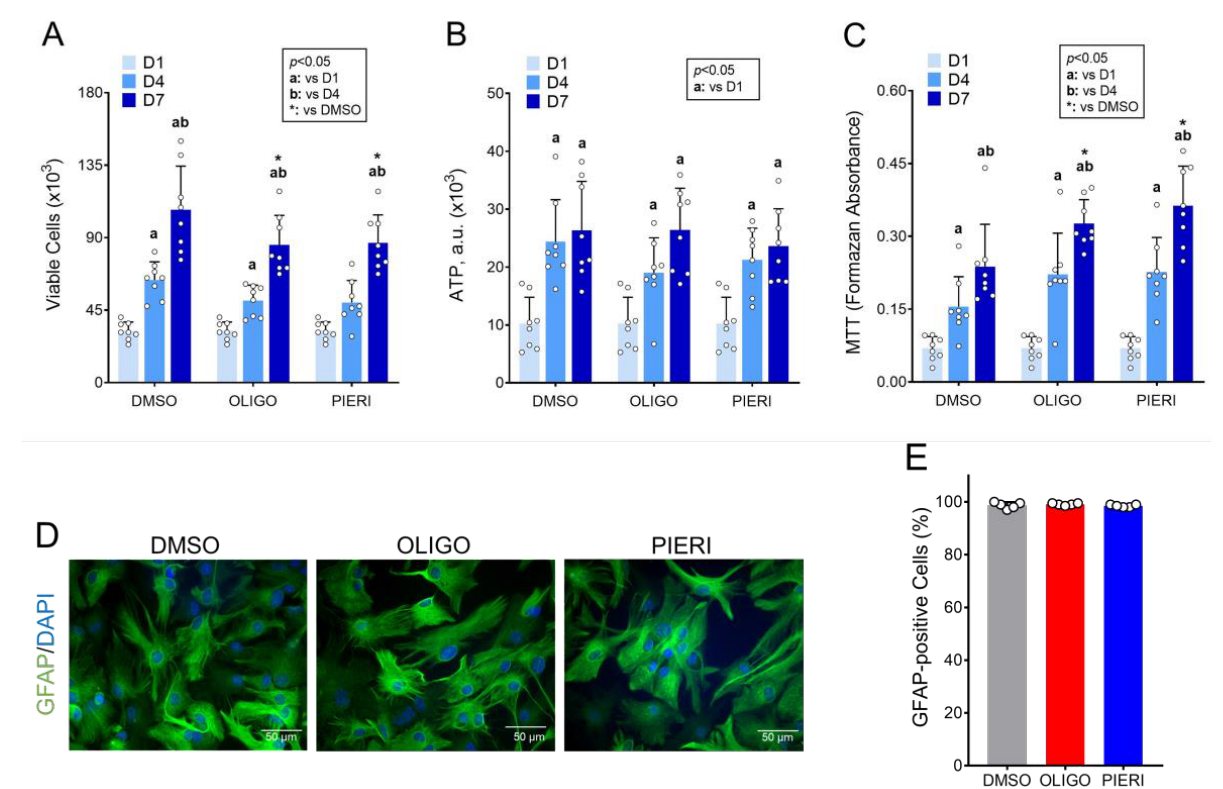
Figure 4. Proliferation and viability of astrocytes cultured in the presence of mitochondrial inhibitors. Astrocytes were cultured in Medium 3, containing DMSO (0.025%, v/v ; solvent), oligomycin (OLIGO; 1 µ g/mL), or piericidin A (PIERI; 2 µ M) from D1. Cells were analyzed after one (D1), four (D4), and seven (D7) days in culture. ( A ) Cell viability by trypan blue. ( B ) ATP content in cultured cells. a.u.: Arbitrary units. ( C ) Cell viability by MTT. ( D ) Microphotographs of astrocytes cultured for four days in the presence of DMSO, OLIGO, or PIERI. ( E ) Percentage (%) of glial fibrillary acidic protein (GFAP)-positive astrocytes within cells cultured in the presence of mitochondrial inhibitors. Cells were analyzed after four days in culture. Statistically significant by two-way ANOVA, post hoc Bonferroni ( p < 0.05); “a” compared to D1, “b” compared to D4, * compared to control (DMSO) at the same time point. N =